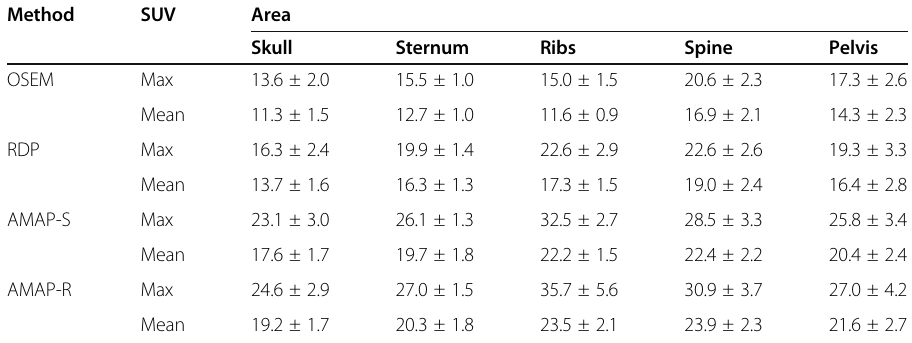
Table 5 Lesion SUV max and SUV mean values (mean ± standard deviation) for the clinical data Method